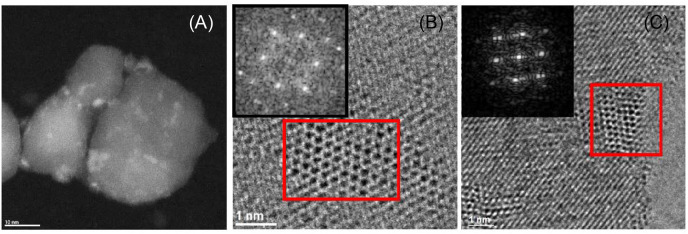
Representative STEM image of MoNB/TiO2-D (A); TEM images and electron diffraction patterns (corresponding to the red squares in the images) of MoNB/TiO2-D (B) and MoNA/ZrO2
(C).